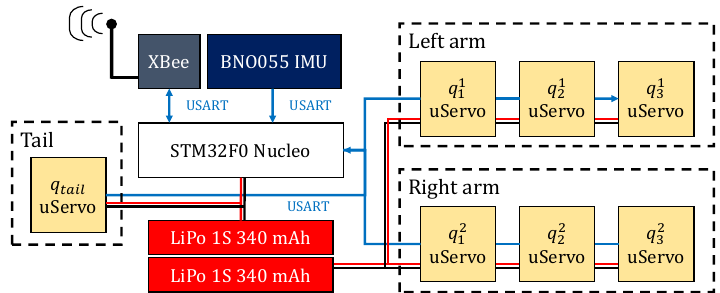
Figure 4. Hardware architecture of the winged aerial manipulation robot.